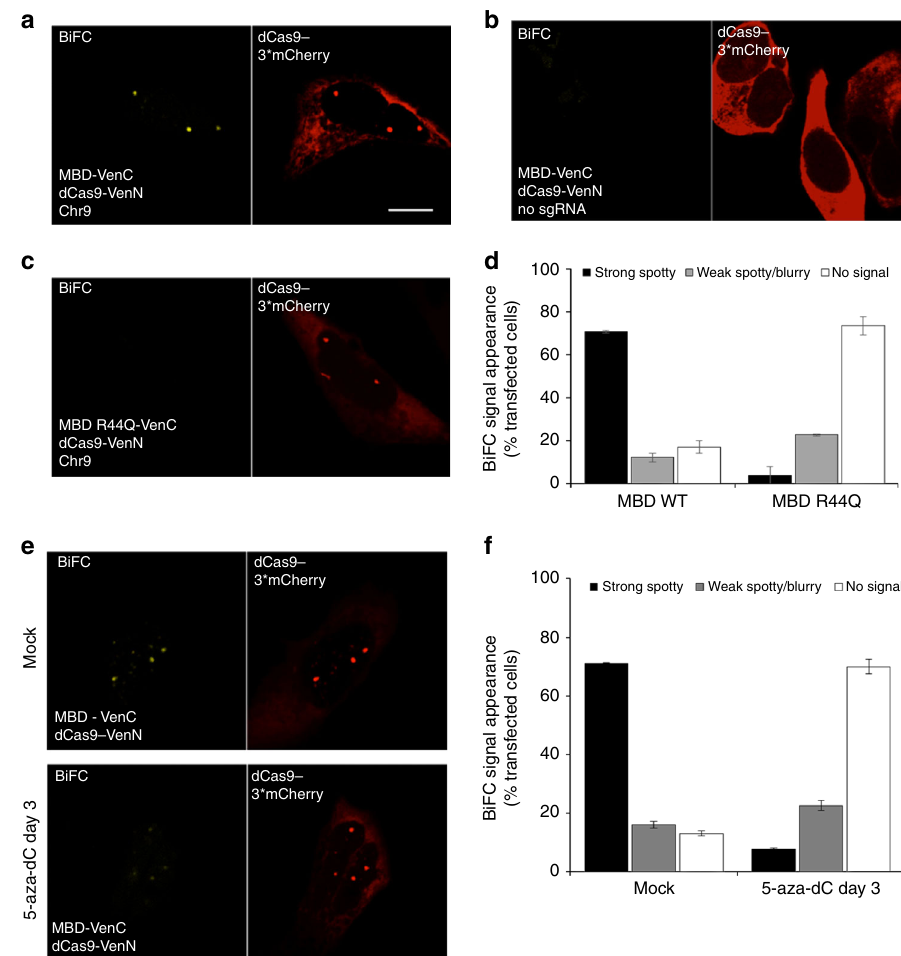
Fig. 5 Development and validation of the BiAD sensor 3. a Representative fl uorescence microscopy image showing strong and sequence-speci fi c BiFC signal obtained with BiAD sensor 3. The locus-speci fi city of the BiFC signal was validated by co-transfecting the BiAD modules with a red fl uorophore- tagged dCas9. b Loss of BIFC signal in the absence of the cognate sgRNA. c Loss of BiFC signal with the R44Q MBD mutant. d Quanti fi cation of the experiments representatively shown in panels a – c . e Representative fl uorescence microscopy images documenting the changes in the intensity of the BiFC signal after a three-day 5-aza-dC treatment of sensor-transfected HEK293 cells. f Quanti fi cation of the experiments representatively shown in panel e . Error bars in all images represent the s.e.m. for two biological replicates (for details cf . Supplementary Tables 3, 6, and 7). All cells were fi xed at 48 h after transfection. Scale bar for all images is 10 µ m. The imaging and display settings of the images shown in panels a – c and within e are